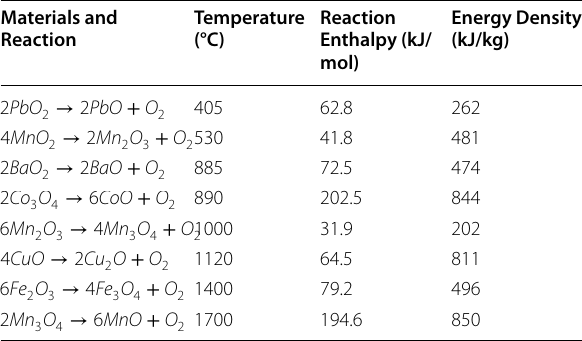
Table 12 Candidate materials for the TCS system based on the redox reaction [241] Materials and Reaction